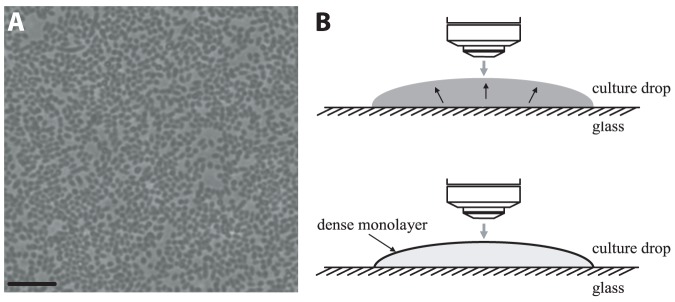
Observation of the collective dynamics of WT S. marcescens 274 bacteria, swirling in a drop.(A) A snapshot of an overnight (18 h) culture-drop placed on a glass slide; image taken by an upright phase contrast microscopy. All cells are spherical and are located on the upper surface of the drop. Bacterial density (fraction of area occupied by bacteria) ρ = 0.67. Scale bar equals 10 µm. (B) A schematic side view, illustrating how cells swim from a homogeneously dense volume to the upper surface of the drop, forming a dense monolayer and an extremely sparse bulk.